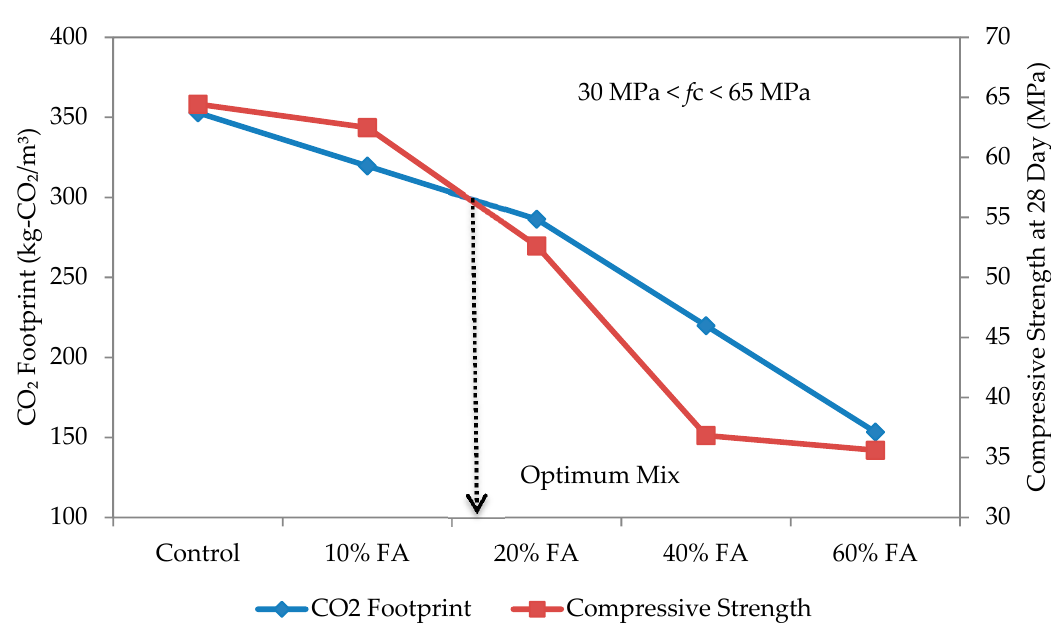
Figure 16. Optimum mix for self-compacting mortar at w/b 0.45.